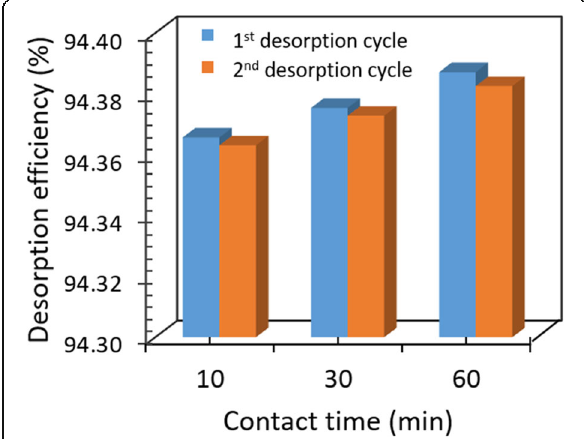
Fig. 7 Ni (II) desorption cycles for the investigated reduced graphene oxide (rGO)